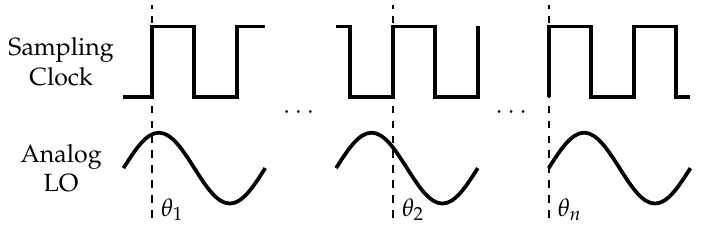
Figure 4. Different analog LO phases at different trigger times.